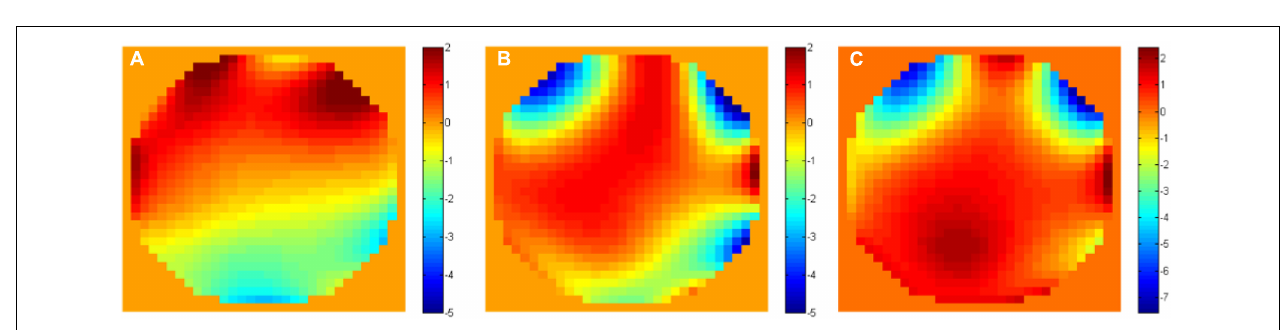
FIGURE 6 | Dependency of signal improvement by AO correction (i.e., the ratio of the sum pixel values of a neuron before and after AO) on the field of view: hippocampal neurons at 1120 µ m depth before (A) and after (B) AO correction. To better quantify the signal improvement for neurons labeled in panels (A,B) , we show in panels (C1–C8) cross-sections of lateral line profiles measured before (blue) and after (green) AO correction. All plots are normalized so that the maximal signal before correction is one. The numbers correspond to the neurons indicated in panels (A,B) . (D) Signal improvement factors as a function of distance from the exact location for AO